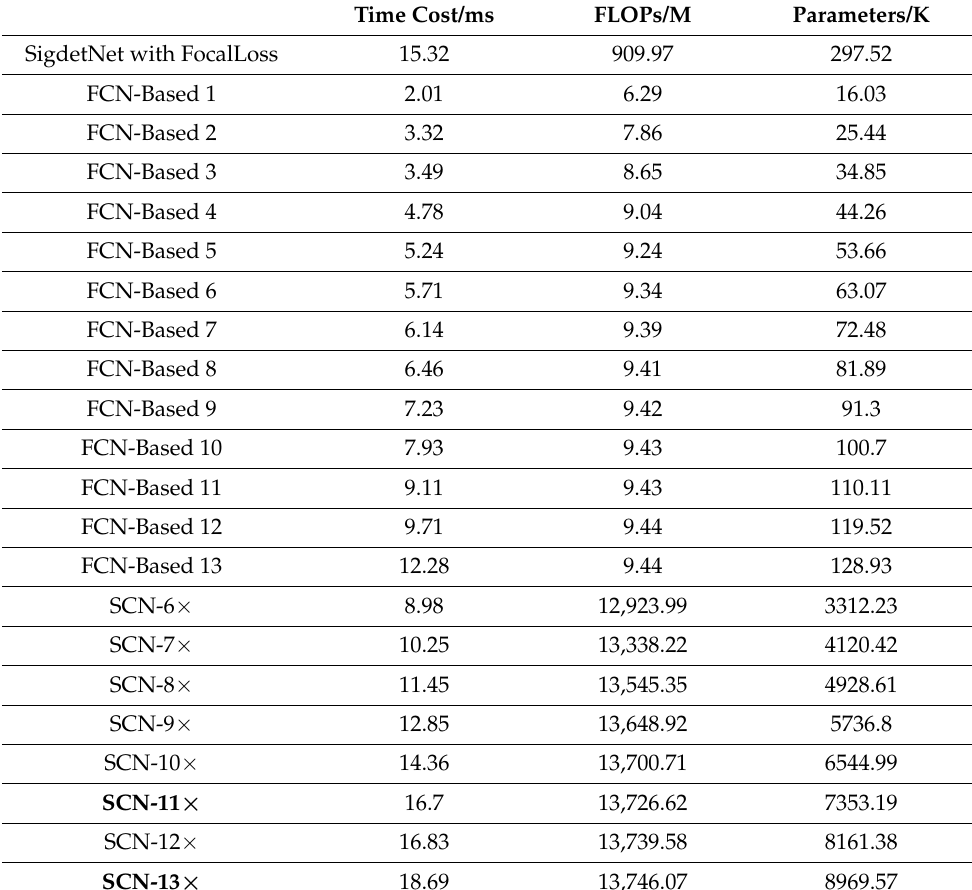
Table 3. The complexity comparison between the proposed method and the other deep learning-based